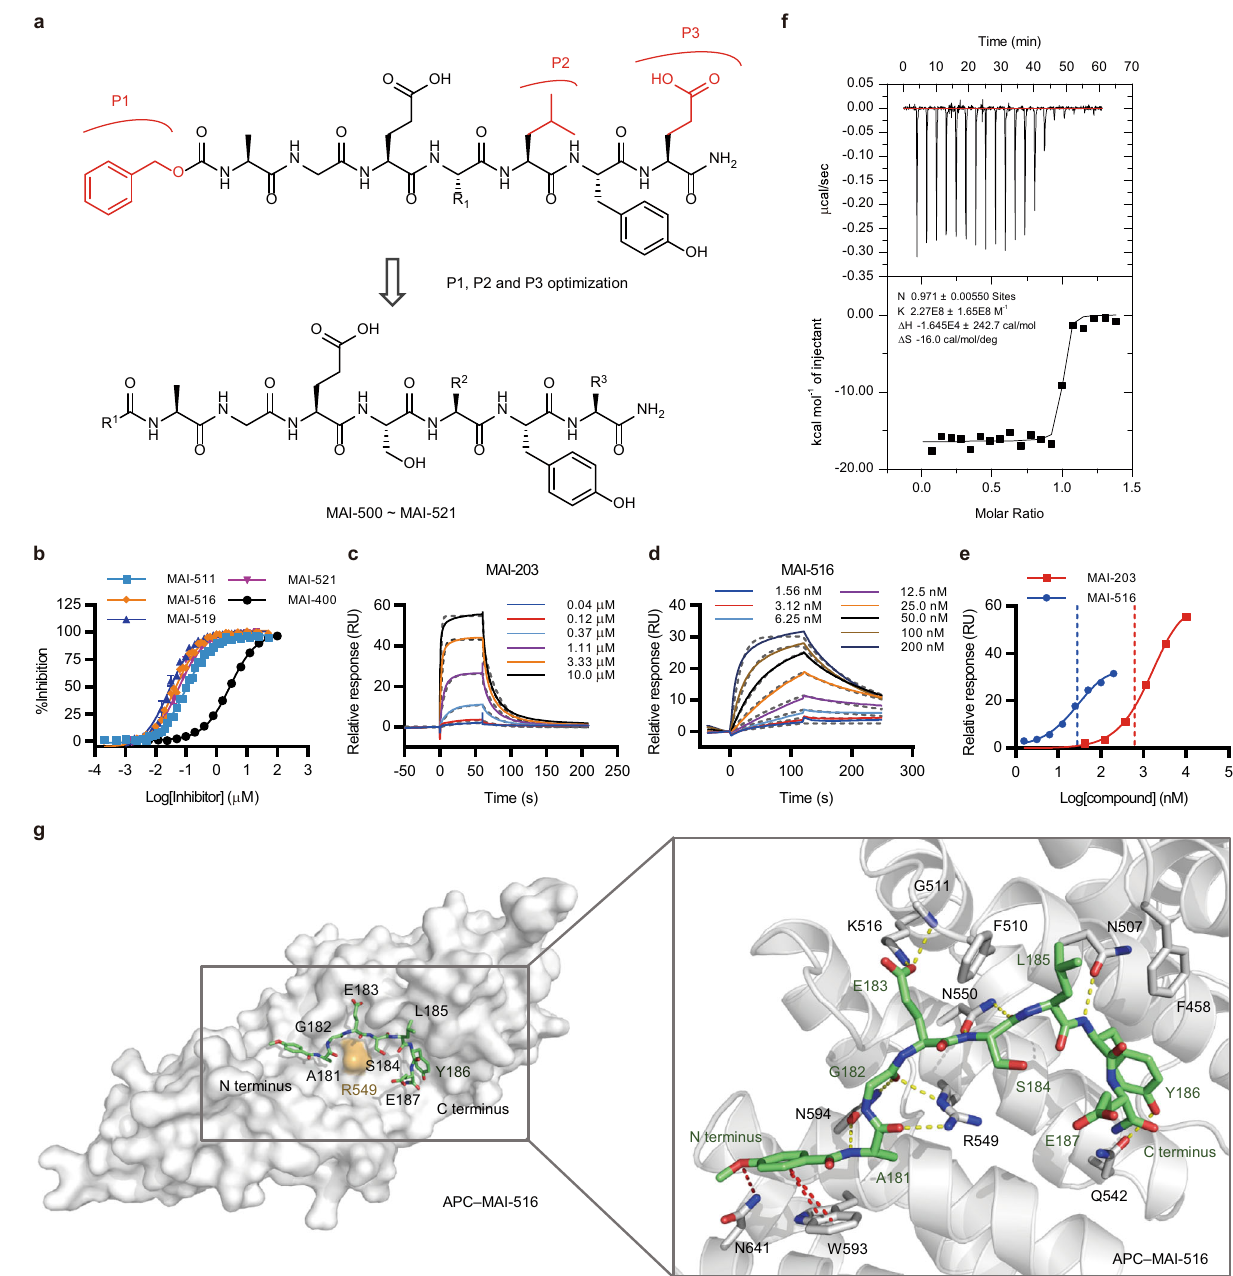
Fig. 3 | Design, biochemical and structural characterization of high-af fi nity APC – Asef inhibitors with tracer 7. a The optimization strategy of APC – Asef inhibitorsbasedonthestructureofMAI-400.P1,P2,andP3(red)weremodi fi edby the rational optimization strategy. b Competitive binding curves for MAI-511, MAI- 516,MAI-519,MAI-521,andMAI-400,determinedbyFPassay.Dataarepresentedas the mean±SD; n =3 independent experiments. c , d Representative SPR sensor- grams (solid lines) and corresponding Langmuir 1:1 kineticmodel fi t (dashed lines) forMAI-203 c and MAI-516 d binding to APC. e Representativeplotofthe response